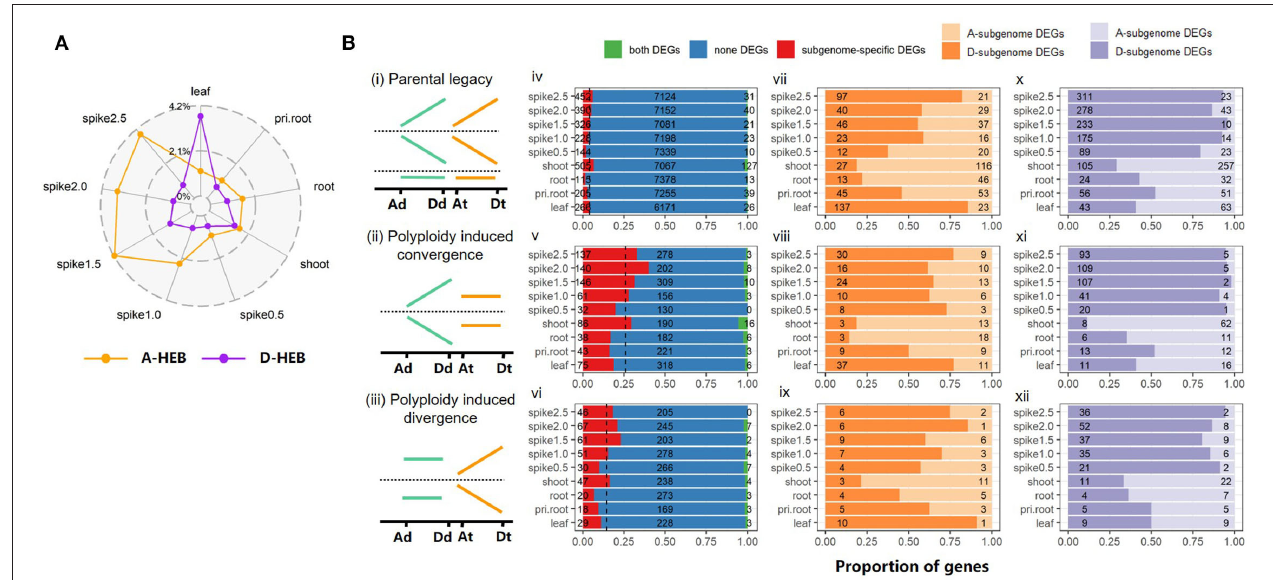
FIGURE 3 | Homoeolog expression bias (HEB) and the contribution of DEG to HEB. (A) The proportion of HEB genes across tissues/stages in AT2. Orange and purple colors represent the A-HEB and D-HEB genes, respectively; (B) Contribution of DEGs on different homoeolog classes. Schematic illustration of three homoeolog categories, including (i) parental legacy, (ii) allopolyploidy-induced convergence and (iii) allopolyploidy-induced divergence, are presented in the first column. The relative expression levels of orthologs/homoeologs in different genomes/subgenomes are indicated by relative height of lines. For each category among tissues, the number of three types of homoeolog pairs, including both DEGs (all two mates of a homoeolog pair are DEGs, green), subgenome-specific DEGs (only one mate of a homoeolog pair is DEG, red), and none-DEGs (all two mates of a homoeolog pair are not DEGs, blue), are shown in the second column (iv–vi); A- (light orange color) and D-upregulated (dark orange color) DEGs (vii–ix), as well as A- (light purple color) and D-downregulated (dark purple color) DEGs (x–xii) are summarized in the third and fourth columns,